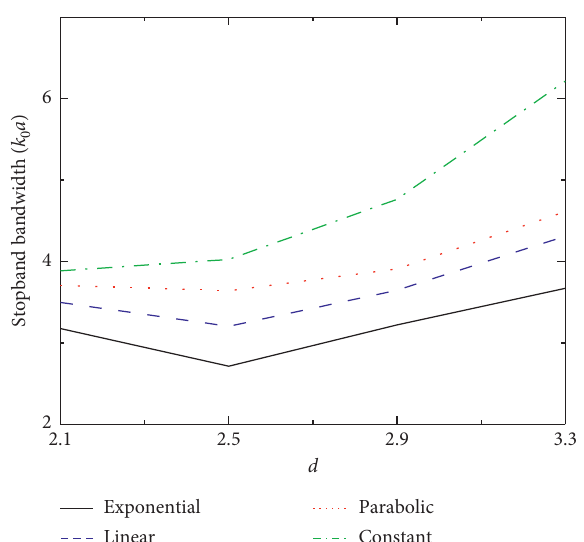
Figure 6: The stopband bandwidths between the backward LSE 10 mode and the forward LSE 20 mode versus the profile parameter d for the constant, linear, parabolic, and exponential